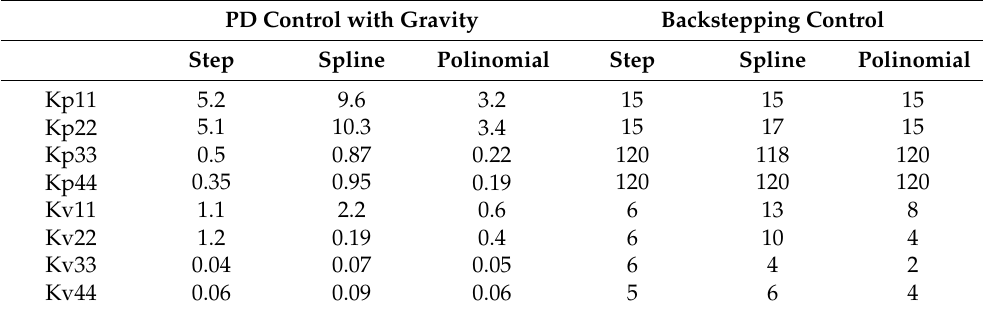
Table 6. Gain values for the nonlinear controllers in different movements of the left arm. PD Control with Gravity Backstepping Control Step Spline